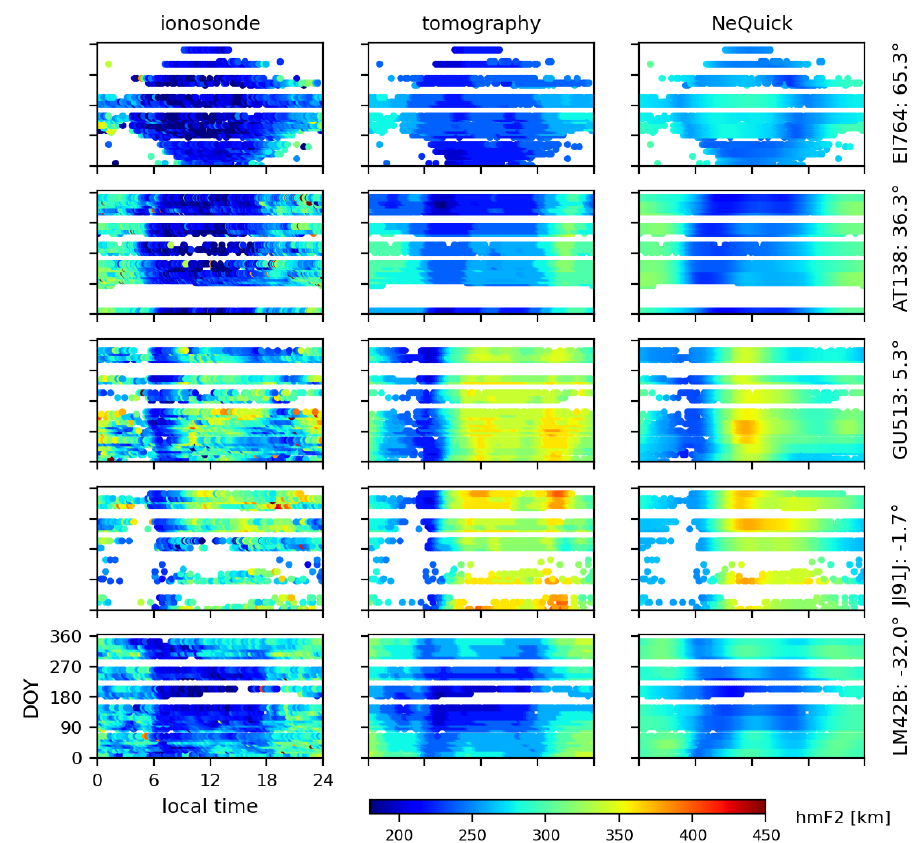
Figure 7. Peak height estimated in five ionosonde locations using GIRO dataset ( left ), tomography ( middle ) and NeQuick ( right ) in terms of local time and day of year of 2018. White spaces represent lack of data.